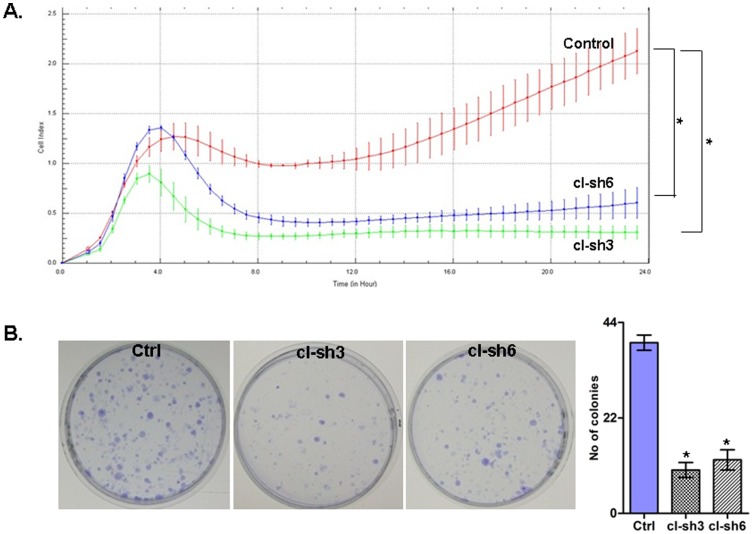
ShRNA-mediated knockdown of the RUNX2 expression in SKOV3 cells.A, effect on cell proliferation; B, Representative images of colony forming assays following RUNX2 knockdown. Error bars denote ± SEM; *indicates statistical significance (P<0.05).